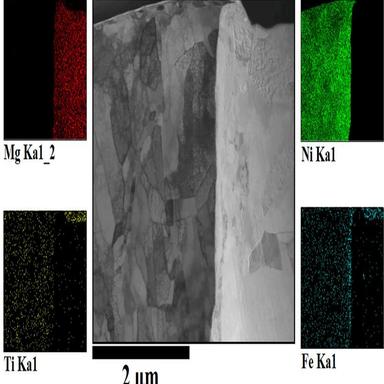
EELS elemental mapping analysis results showing the elemental distribution across the fold-forged Mg/Ni interface.